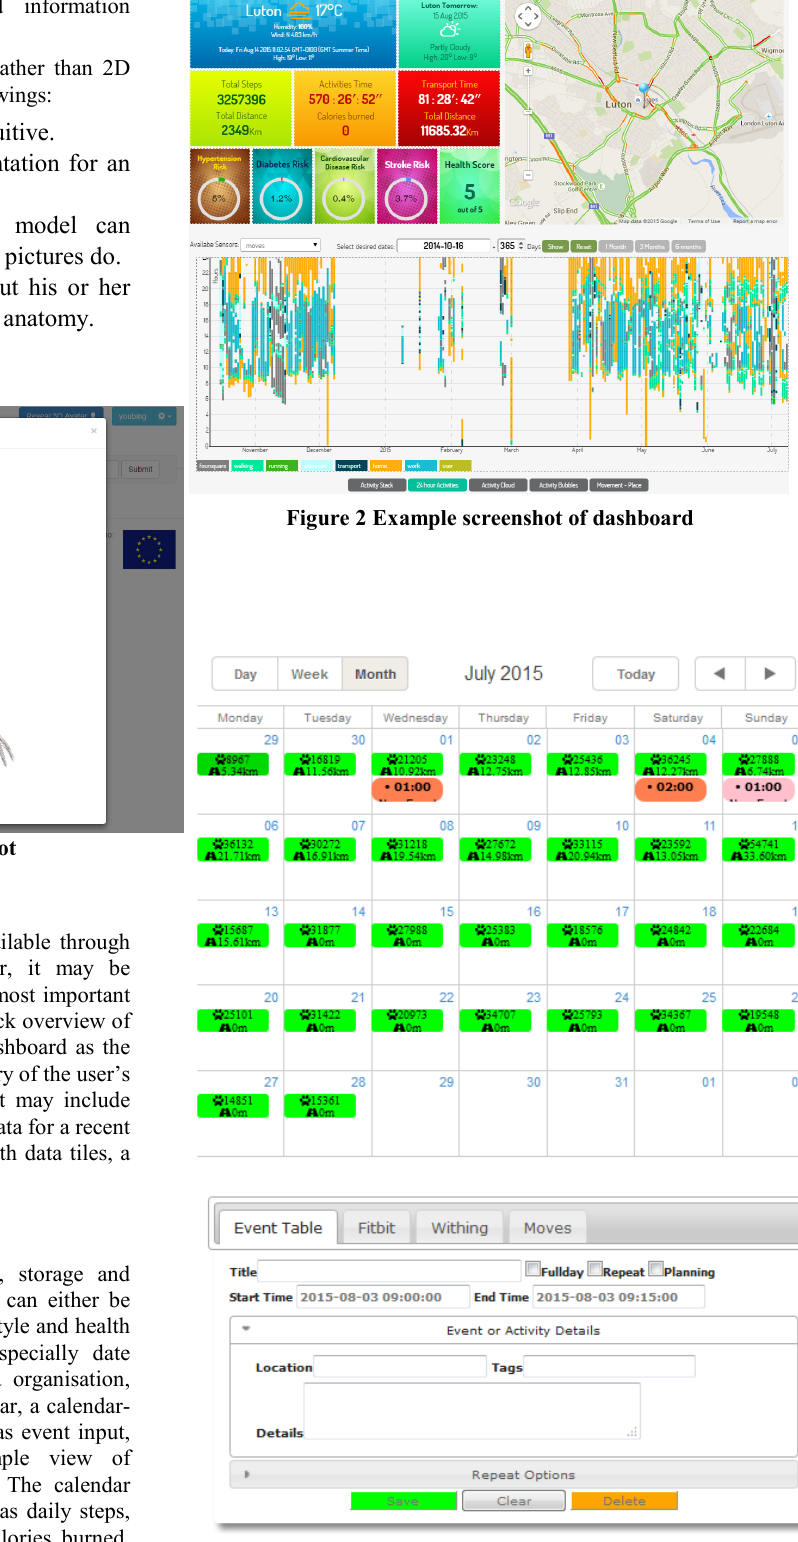
Figure 3 An example view of the diary and event